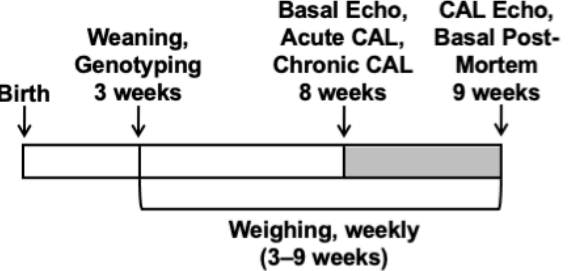
Figure 6. Schematic of age at experimental time points: Weaning and genotyping (3 weeks); basal ultrasound echocardiography (Echo) with Doppler flow, acute coronary artery ligation (CAL), chronic CAL induction (all 8 weeks); CAL Echo, and basal post-mortem (9 weeks); weekly weigh- 9 ing (3–9 weeks).